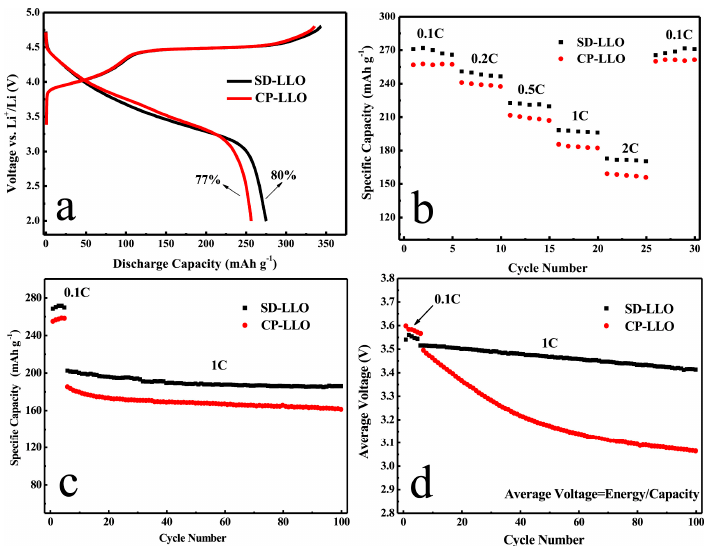
Figure 13. Comparison of two samples of Li-rich oxide 0.5Li 2 MnO 3 -0.5LiMn 1/3 Ni 1/3 Co 1/3 O 2 obtained by a spray-drying procedure (SD-LLO) or by a dry mixing procedure (CP-LLO)—see text for details. ( a ) First cycle charge/discharge profiles; ( b ) Rate performance; ( c ) Cycling performance between 2 and 4.8 V; ( d ) Average discharge voltage as a function of cycle number during cycling. (Reproduced from [149]. Copyright (2015), with permission from Elsevier).